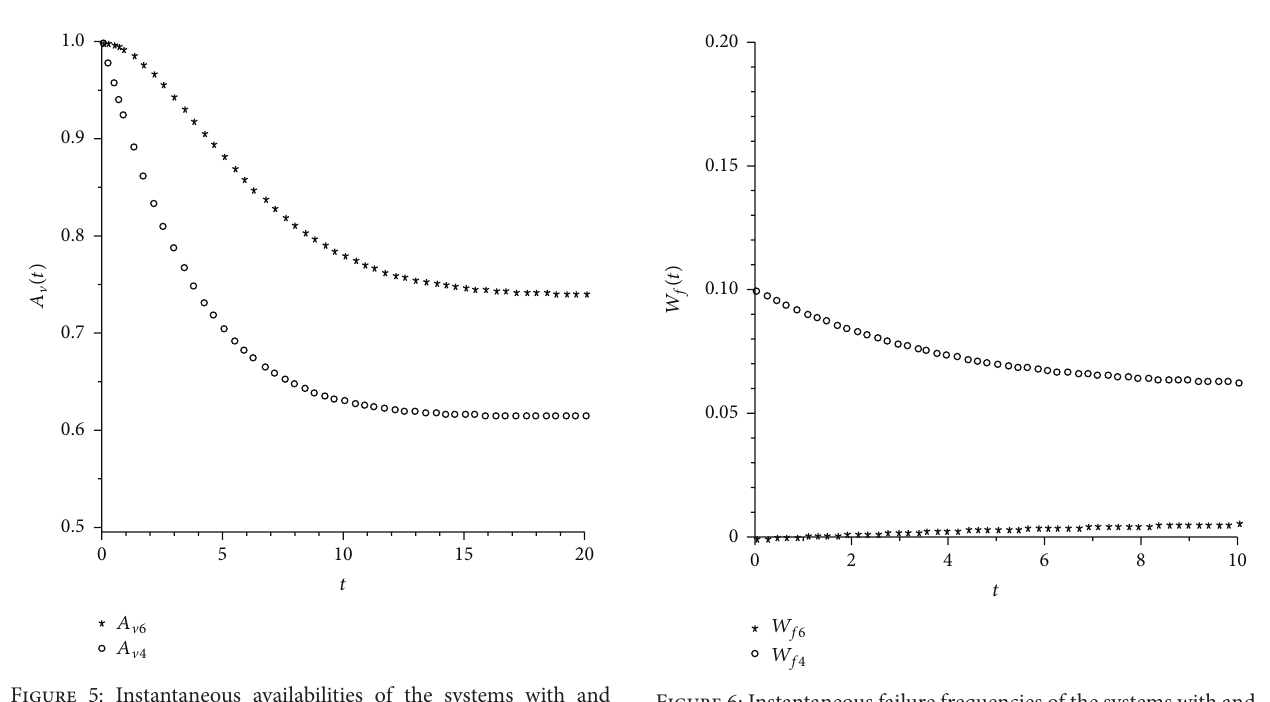
Figure 5: Instantaneous availabilities of the systems with and without warning device.